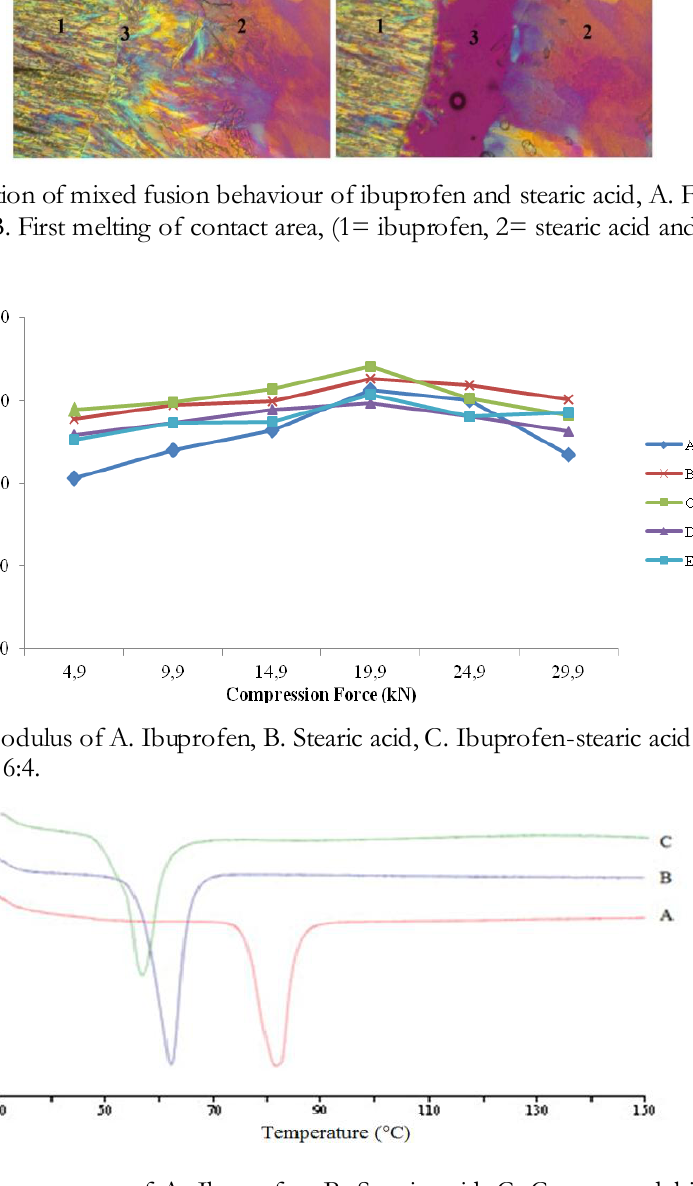
Figure 3. DTA thermograms of A. Ibuprofen, B. Stearic acid, C. Compressed binary mixture of ibuprofen-stearic acid of 4:6 weight ratio at